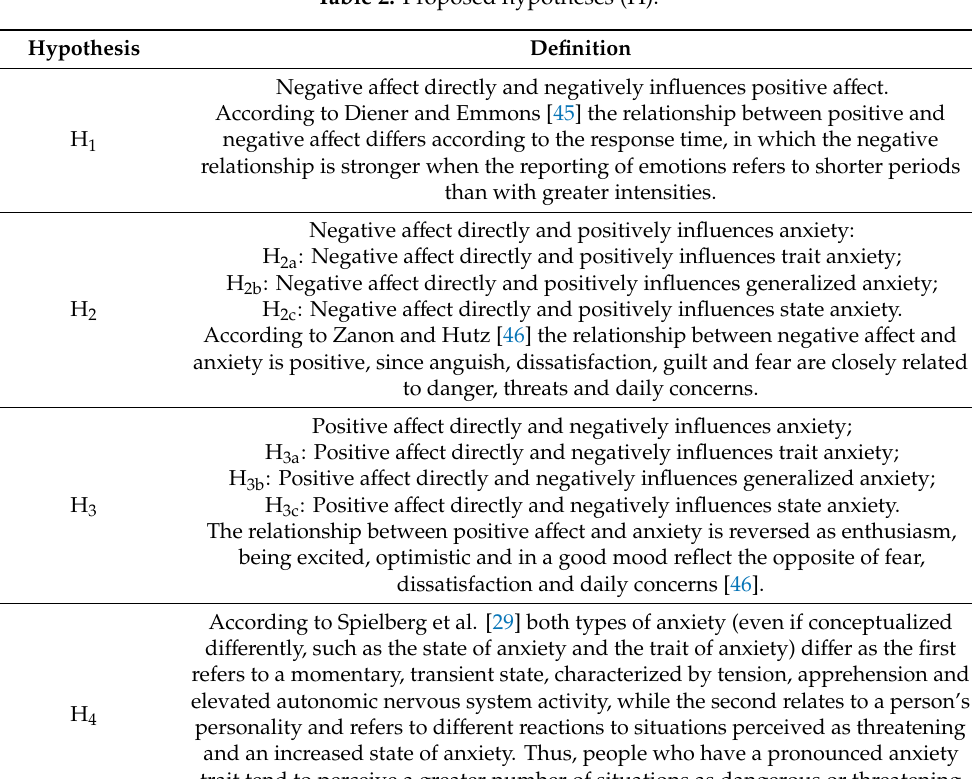
Table 2. Proposed hypotheses (H).